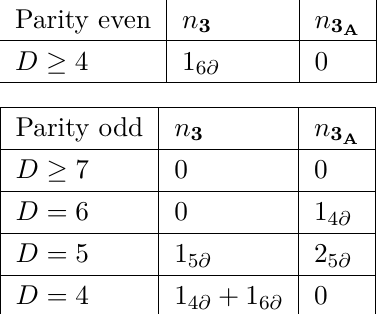
Table 11 . The counting of non-quasi-invariant photon structures along with their S 3 representation and derivative order. The counting for D = 5 is the same as that for D ≥ 7